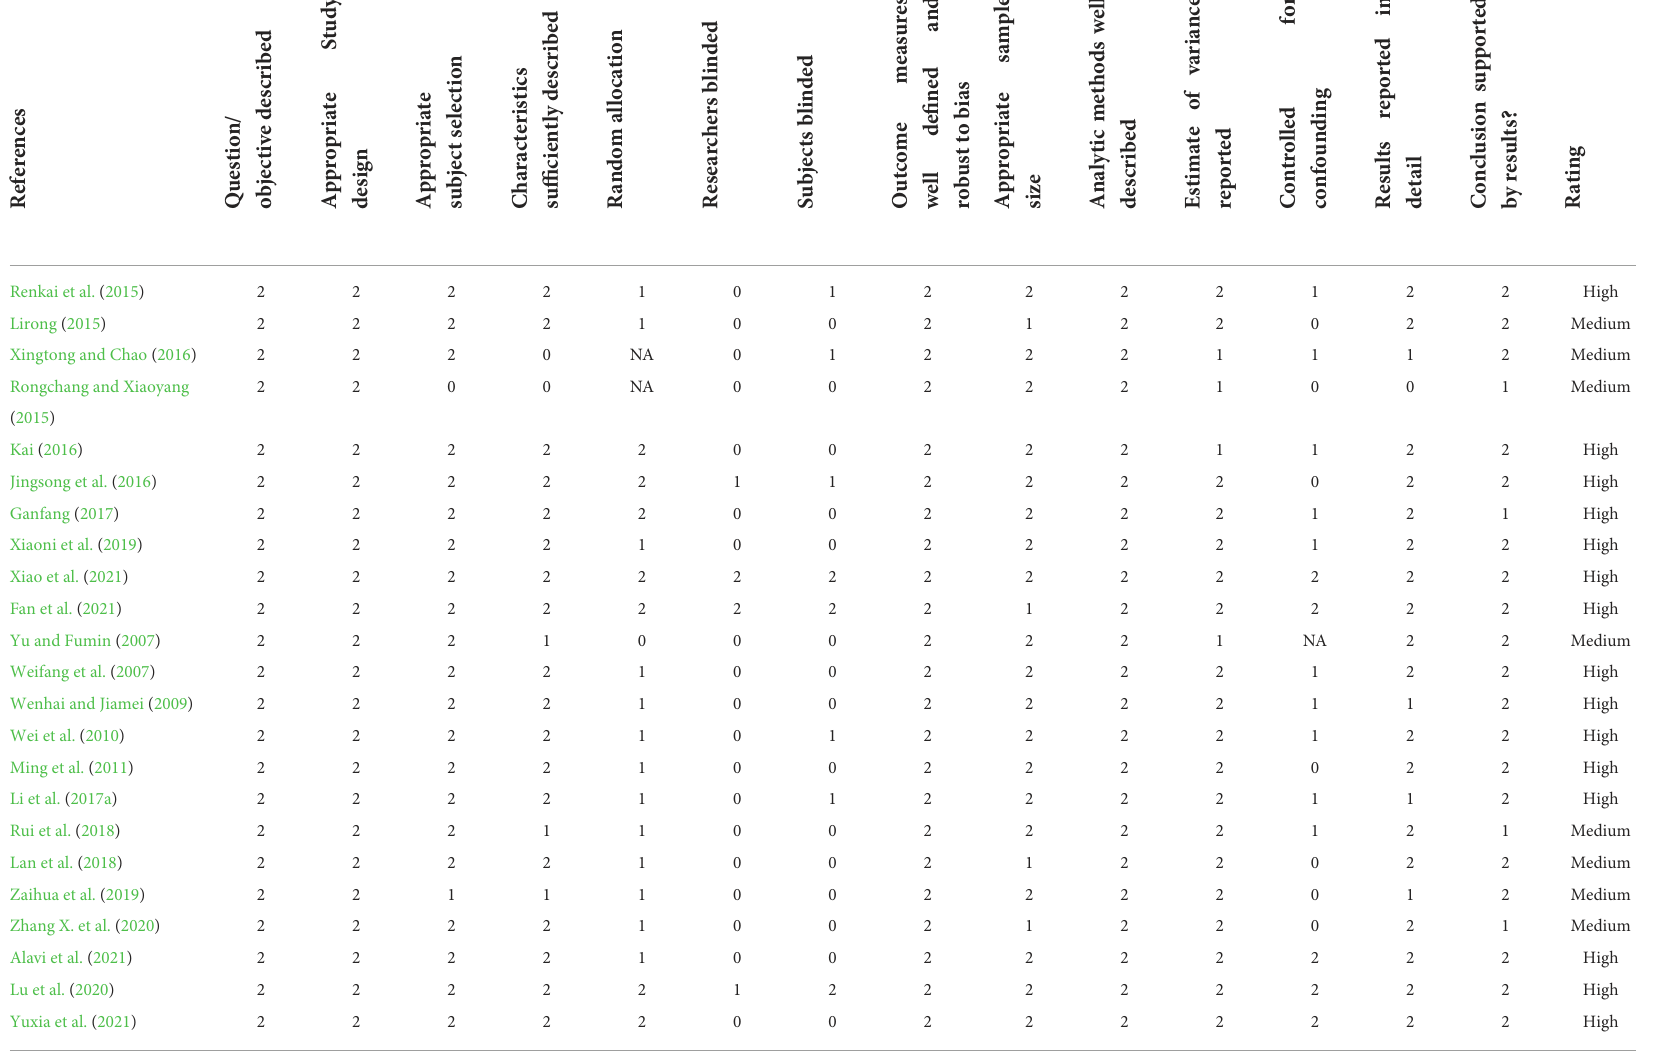
TABLE 1 Quality assessment